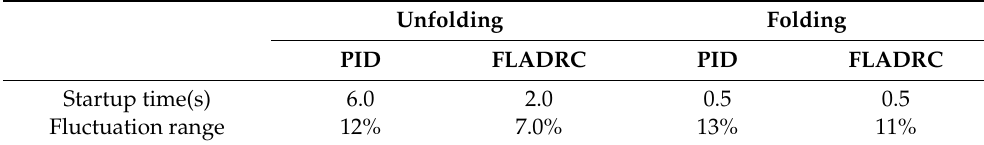
Table 5. Assessment indices of cylinder #4 motion control using PID and FLADRC.